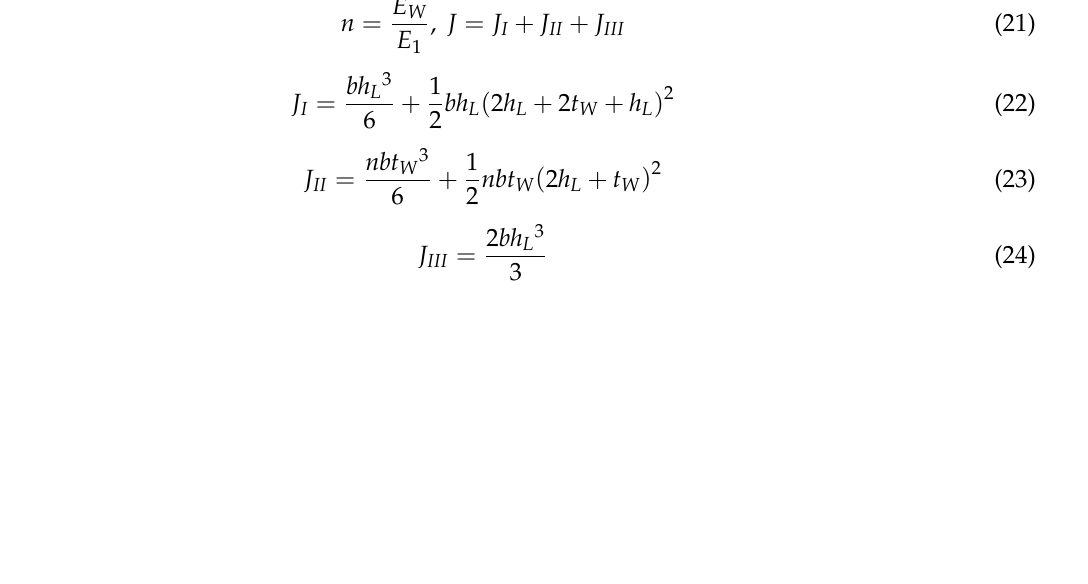
Figure 23. Cross-section of BWW-type samples including the parameter notation used in the text.